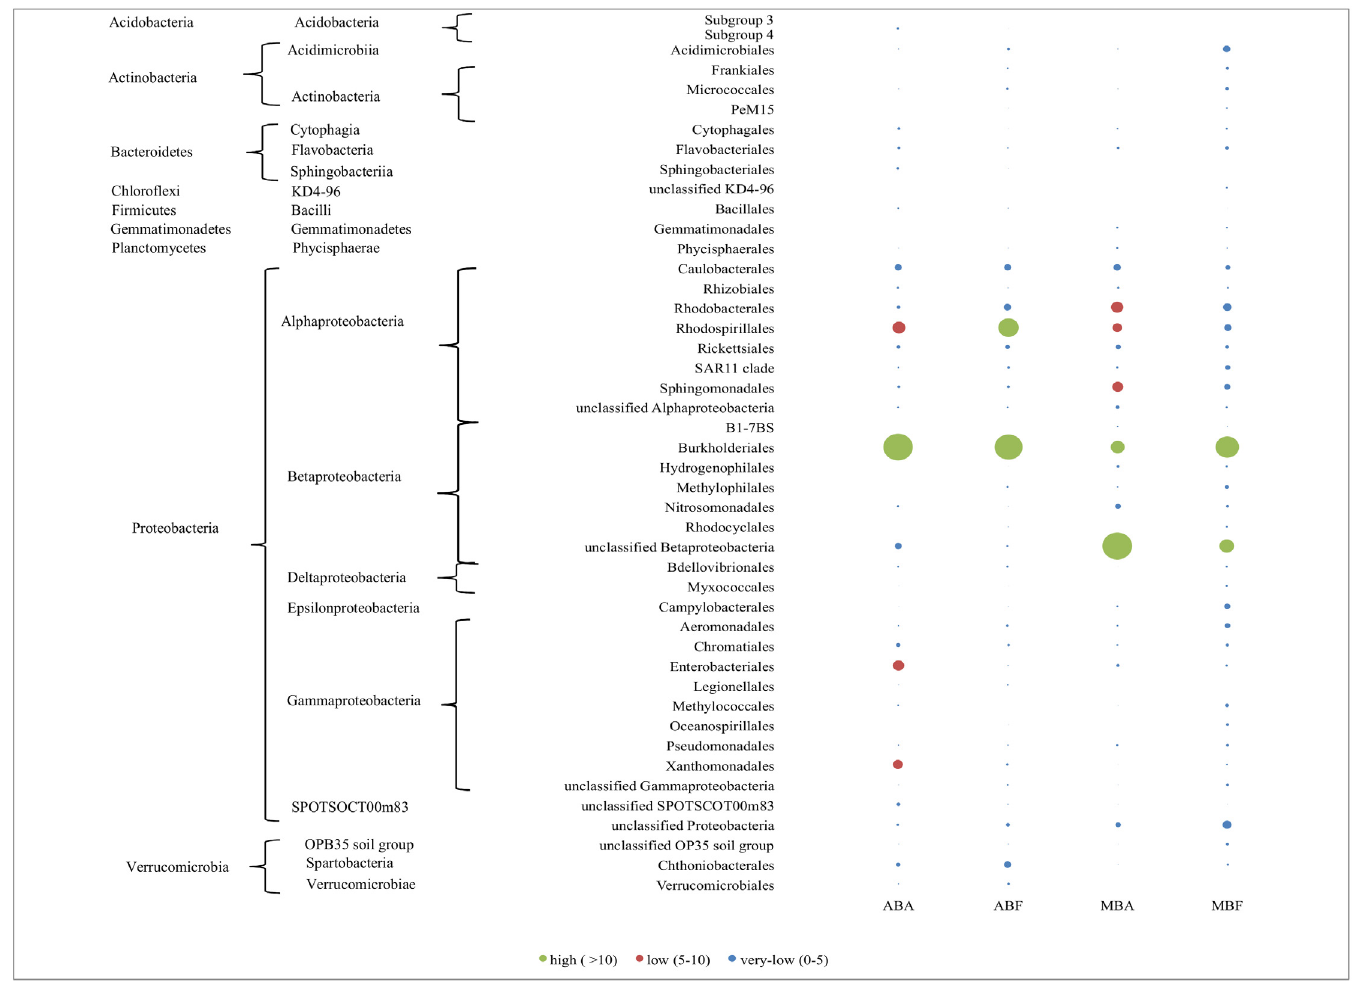
Fig 4. Distribution of the first 100 dominant bacteria OTUs at the order level, expressed as the proportion of the average number of reads obtained from each sample after normalization to the smallest sample. (n = 3402 reads). Circle size indicates the abundance relative to the whole sample for each cyanobacterial species: Anabaena (AB) and Microcystis (MB)) and fraction: free living (F) or associated (A)